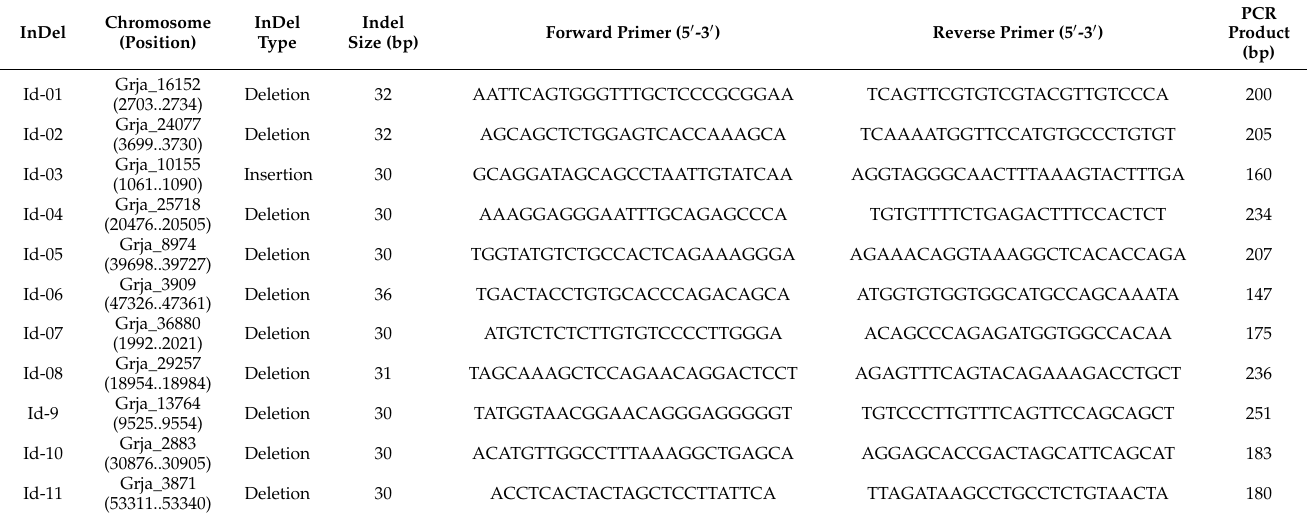
Table 1. Eleven InDel markers and primers to detect